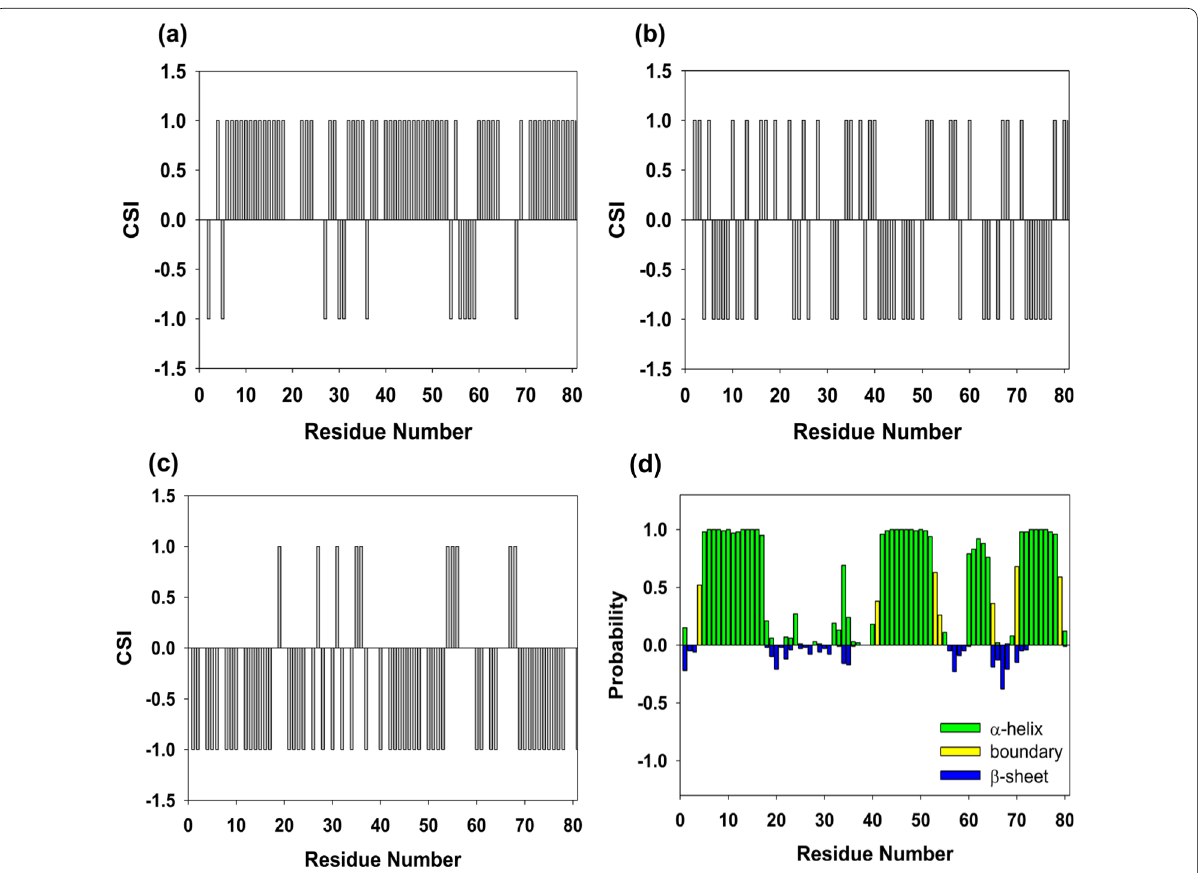
Fig. 3 13 C and 1 H chemical shift indexes derived from a 13 C α chemical shifts (Δ 13 C α (Δ 13 C β 1, 1 and Δ 13 C β 1, 1), c 1 H α chemical shifts (Δ 1 H α ≥ + + ≤ − − chemical shift for that residue type subtracted from the 13 C α chemical shift of each residue. Δ 13 C β and Δ 1 H α were also calculated in the same way (Wishart and Sykes 1994; Wishart et al. 1992). The values of values of 1, 0, 1 in 1 H CSI indicate β-sheet, random coil, and α-helix, respectively. d Secondary structure prediction using the PECAN algorithm − + (Eghbalnia et al.